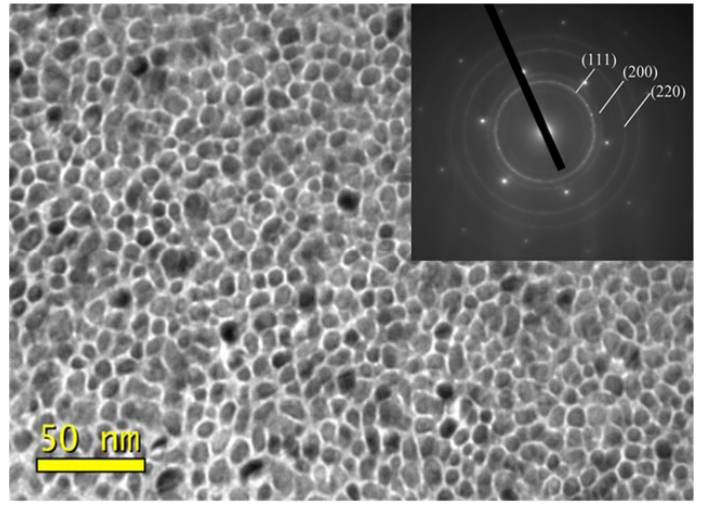
Figure 5. Plane ‐ view TEM images of sample C1 and its diffraction pattern in the inset. Figure 5. Plane-view TEM images of sample C1 and its diffraction pattern in the